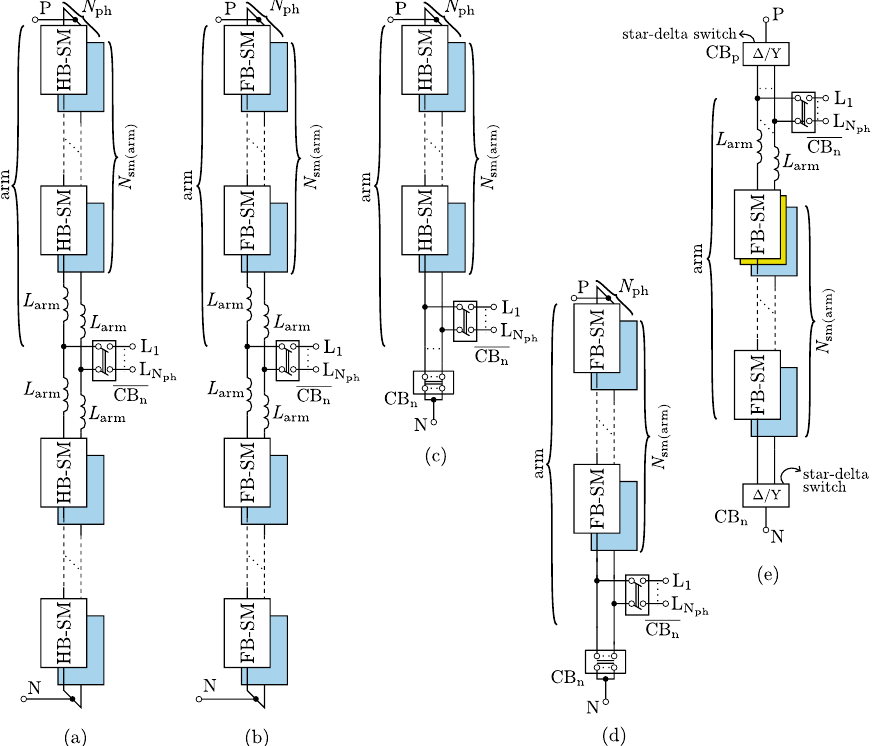
Figure 1. Schematic of battery-integrated modular multilevel converters (BI-MMCs) for an N ph -phase system during DC charging. ( a ) Double-star half-bridge (DSHB), ( b ) double-star full-bridge, ( c ) single- star half-bridge (SSHB), ( d ) single-star full-bridge (SSFB), and ( e ) single-delta full-bridge (SDFB) topologies